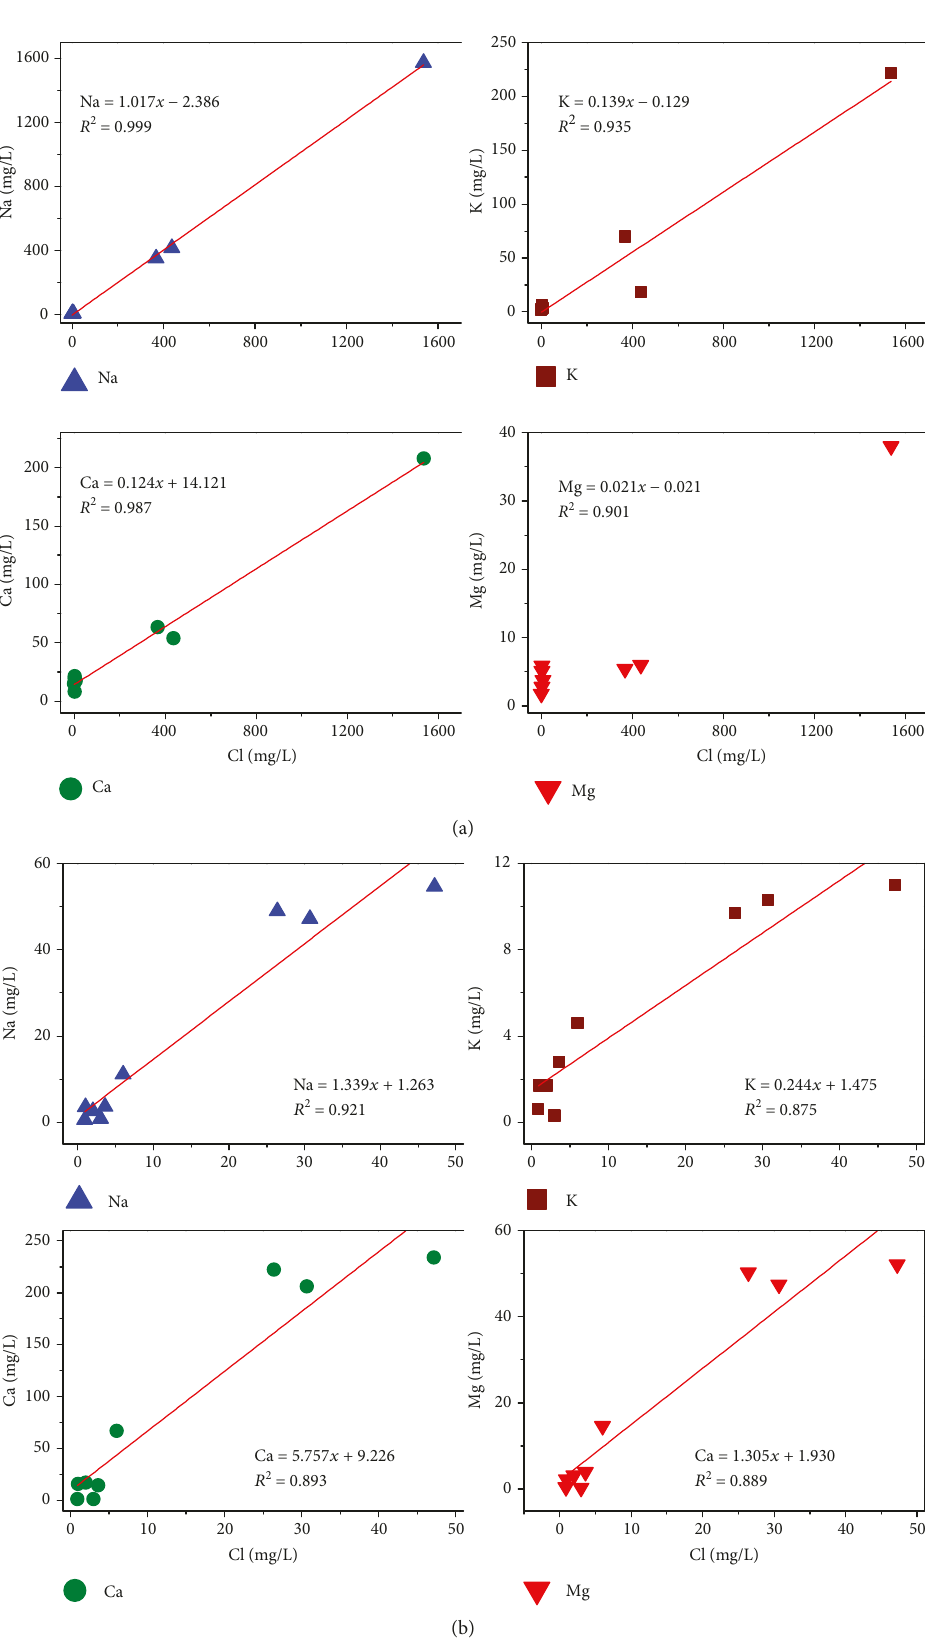
Figure 8: Relation between Cl and Na, K, Ca, and Mg: (a) Coconuco sector and (b) San Juan